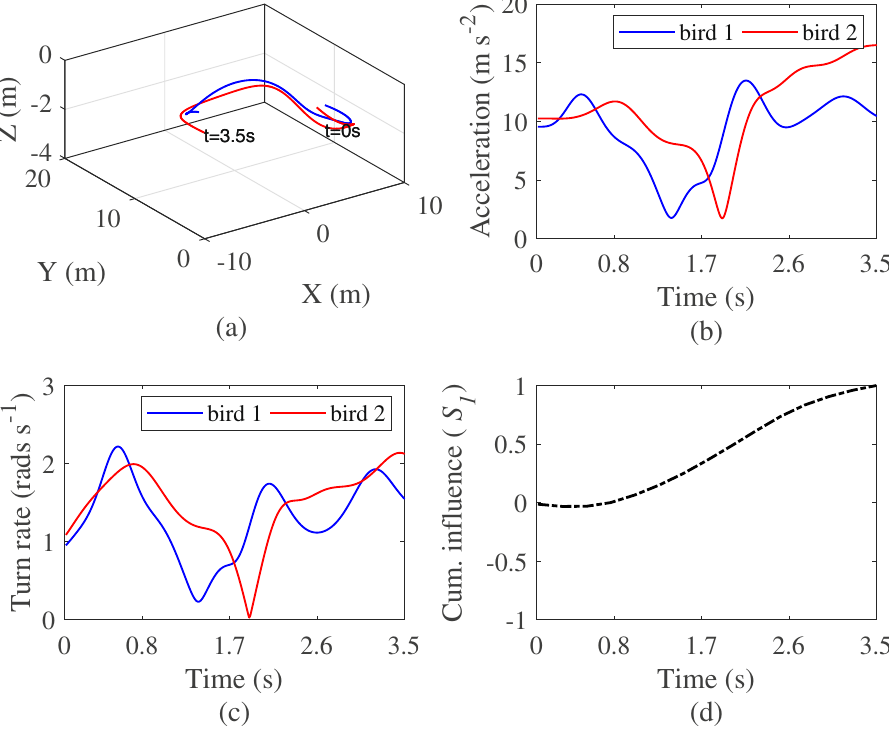
Figure 10. Time trace of the kinematics of a sample tandem flight with ( a ) birds 3D position, ( b ) acceleration, ( c ) absolute turn rate 61 , and ( d ) time evolution of the cumulative influence of bird 1 on 2 resulting in a consistent leadership over time. Note that the values of the cumulative influence in (d), are normalized between − 1 and